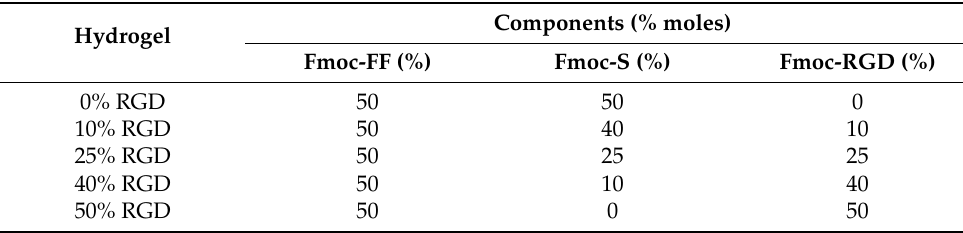
Table 1. Composition of standard Biogelx hydrogel (Biogelx-S) (0% RGD) and custom synthesized RGD-containing